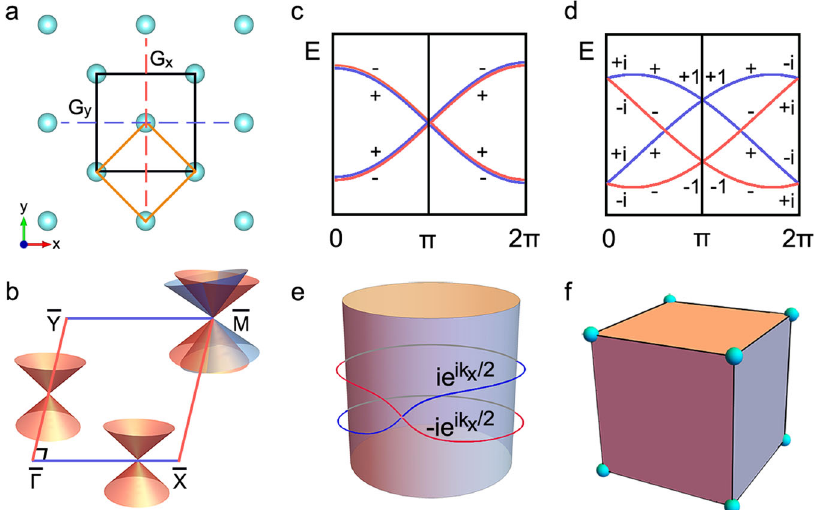
Fig. 1 Schematic demonstration for the wallpaper fermions and third-order topology. a Schematic of wallpaper group p 4 g with two perpendicular glide lines G x = y indicated with red/blue dashed lines. b Two categories of band crossings induced by G x = y along the invariant paths, which are constrained by the commutation relations of G x = y and TG y = x . c When G x = y anticommuting with TG y = x , a fourfold- degenerate Dirac point appears at the zone boundary k = π , i.e., at M as in b . d When G x = y commute with TG y = x , the band crossing is twofold degenerate and an hourglass-shaped dispersion with an internal partner switching for each quadruplet appears. e Due to the G x = y eigenvalues g ± x = y ¼ ± ie (cid:2) ik y = x = 2 , surface states cannot go to the origin after a period of 2 π , but a periodicity of 4 π , featuring a Möbius fermion character. f Schematic of a helical third-order topological insulator with time-reversal polarized octupole